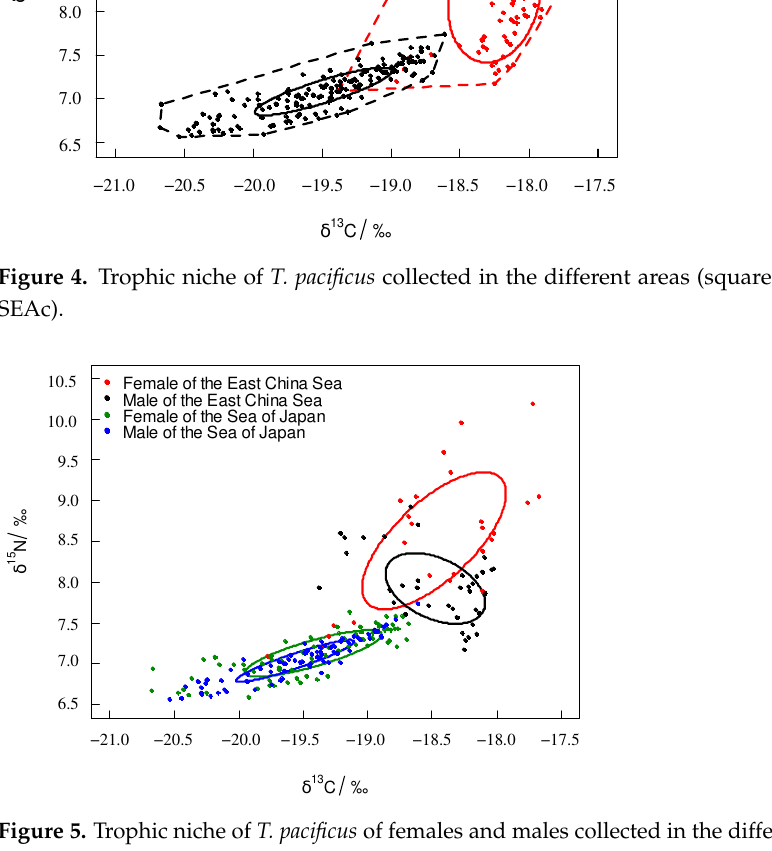
Figure 5. Trophic niche of T. pacificus of females and males collected in the different areas (circle plot: SEAc).